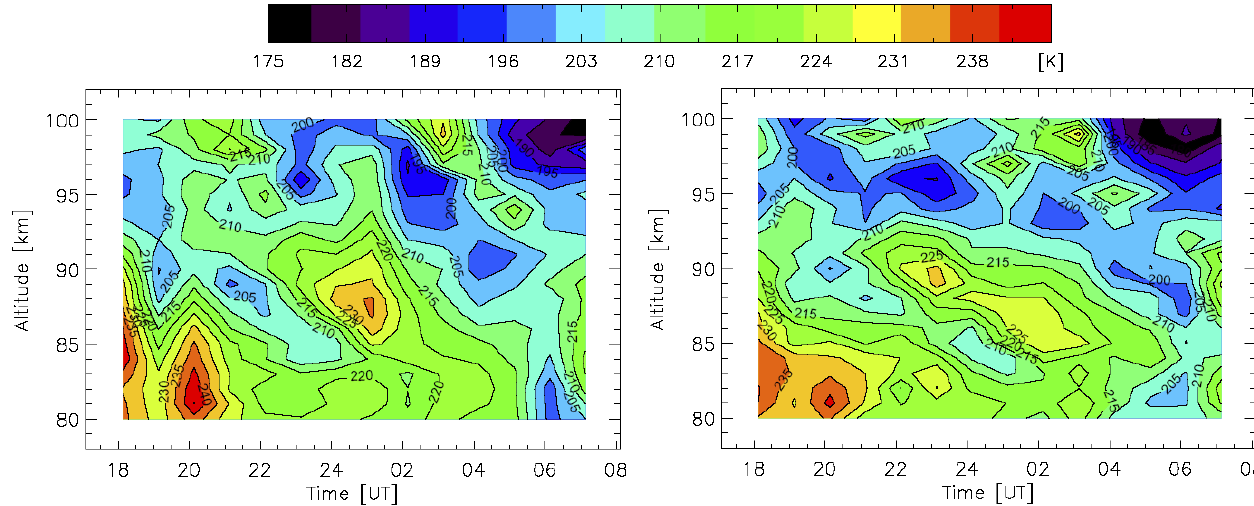
Fig. 9. Contour plots of hourly averaged temperatures from the ALOMAR Weber Na lidar on 21 and 22 January 2005. Beam 1 (left): 20 ◦ W of zenith. Beam 2 (right): 20 ◦ E of